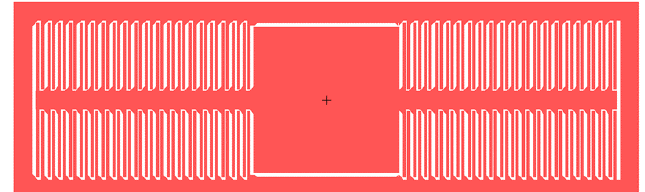
Figure 1. The comb capacitor.